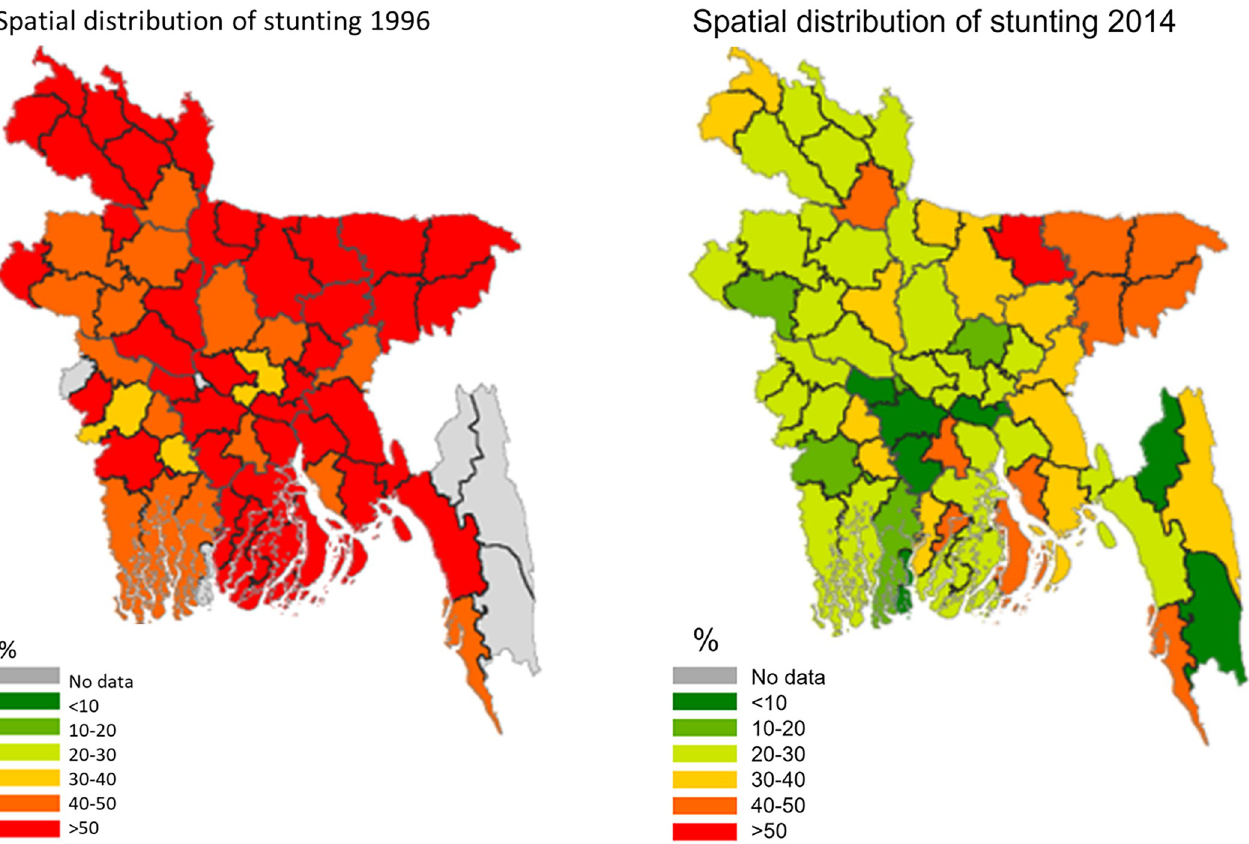
Fig 2. Spatial distribution of total stunting among under-fives. Source: Own calculations with GRCP software.